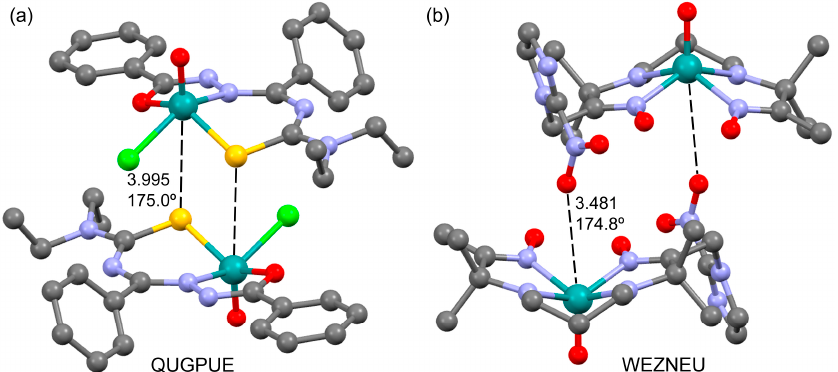
Figure 9. Ball and stick representation of the X-ray structures QUGPUE ( a ) and WEZNEU ( b ). Distances in Å. H-atoms omitted. Color code: Carbon grey, Nitrogen blue, Technetium teal, Oxygen red, Sulfur yellow.